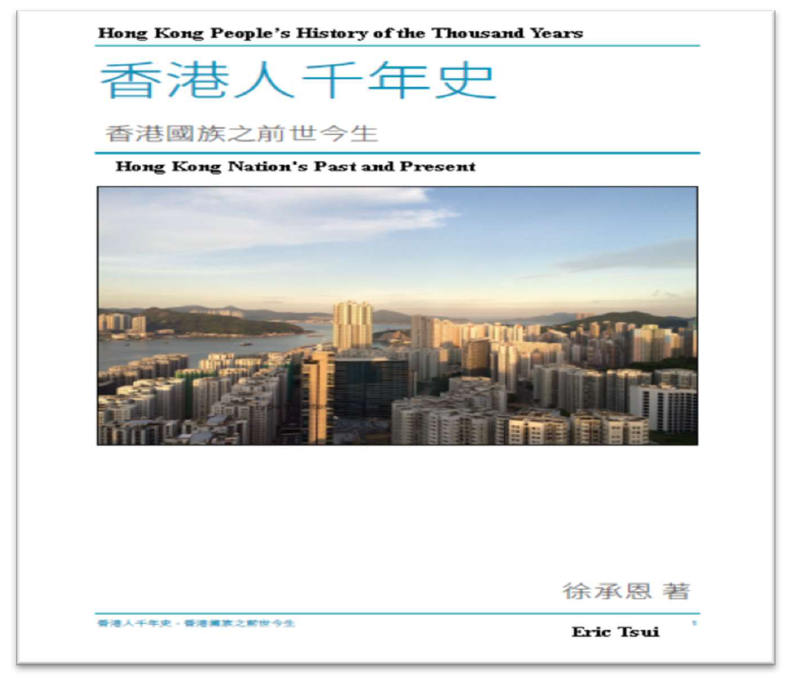
Figure 4. The cover of Eric’s self-made magazine.